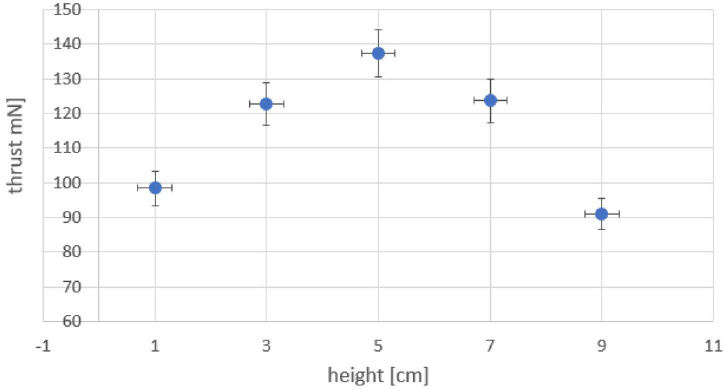
Figure 6. Sample variation of the axial thrust with the height above the propeller at − 98 kV for a RIE with toroidal collector. Error bars are 3 mm height positioning error and 5% estimated measurement thrust